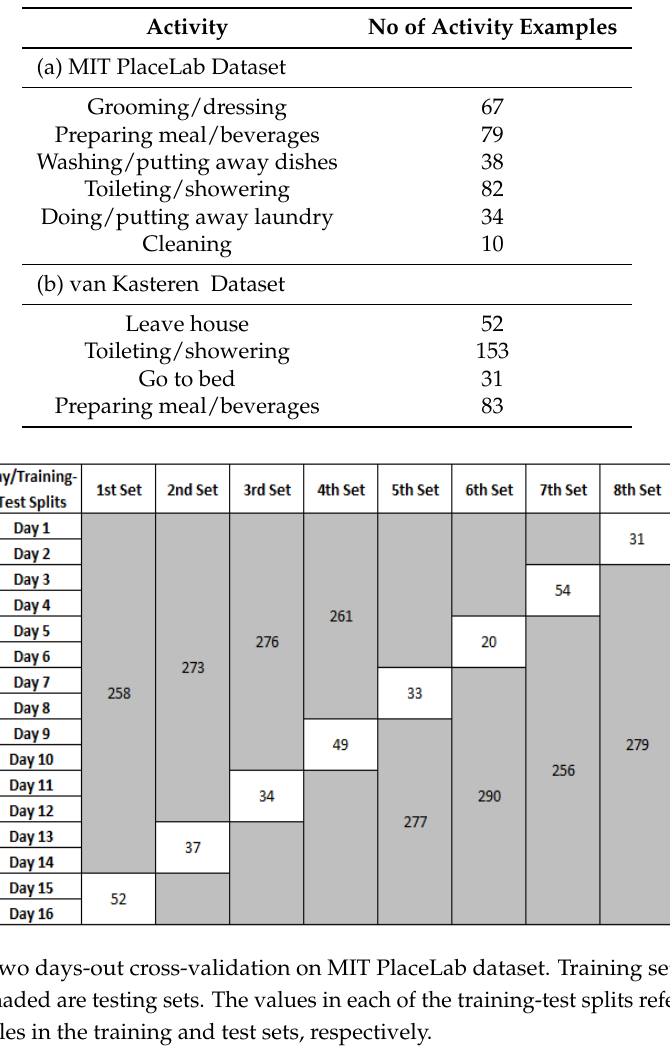
Table 1. Number of activity examples for each activity.